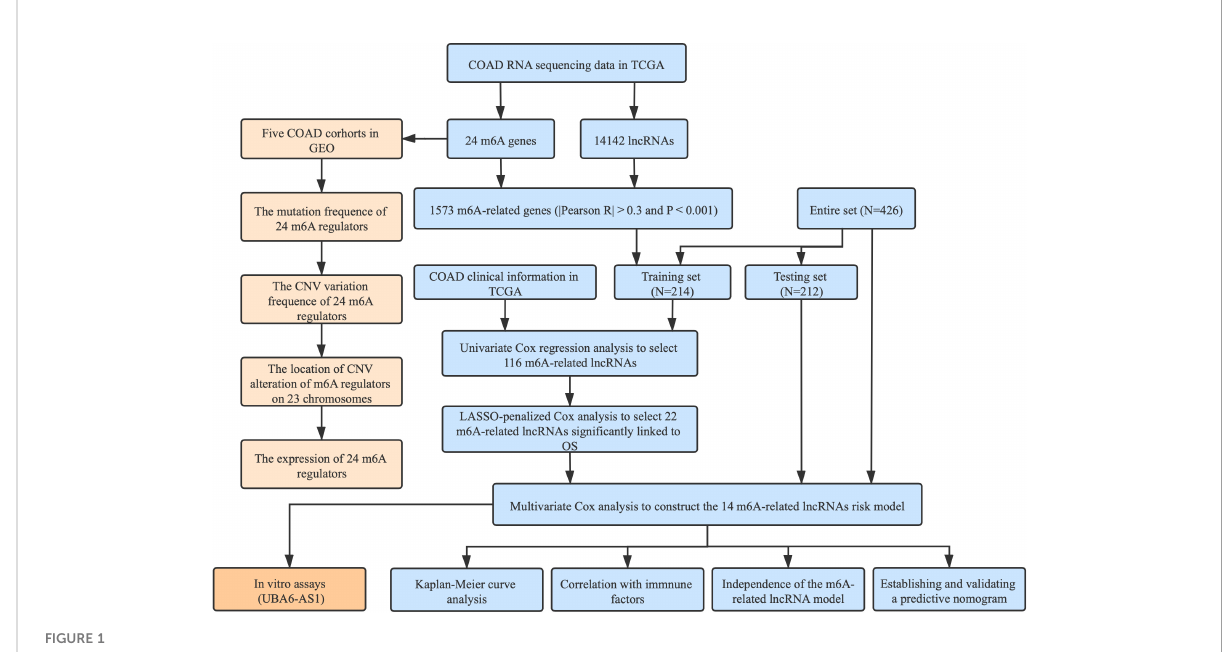
FIGURE 1 Flowchart of this